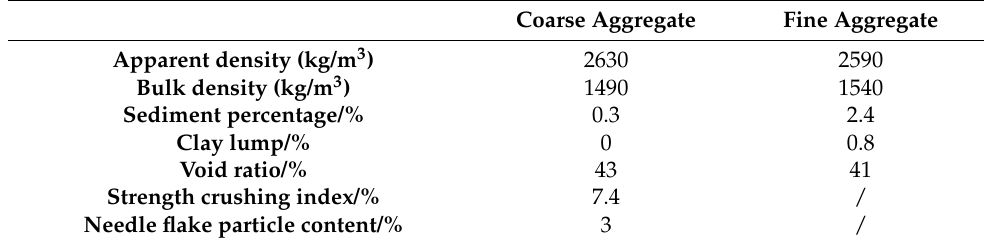
Figure 1. The gradation compositions of coarse and fine aggregates. Table 2. The basic properties of aggregates.